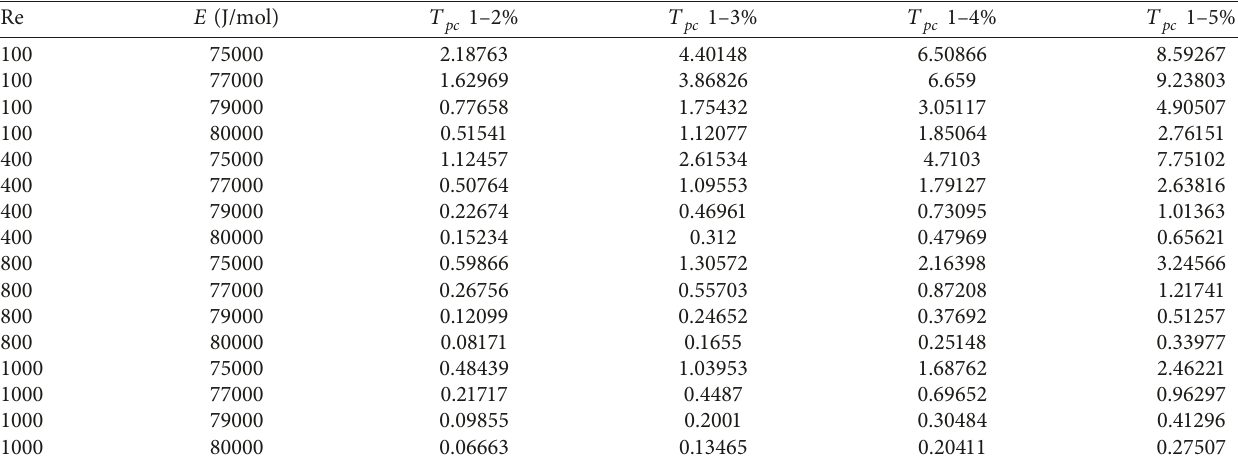
Figure 9: Temperature distribution along the length of the channel: (a) I.C � 5%, E � 80,000J/mol; (b) I.C � 5%, Re � 1000; (c) Re � 1000, E � 80,000J/mol. Table 3: Percentage change of the temperature when initial concentration is changing from 1% to